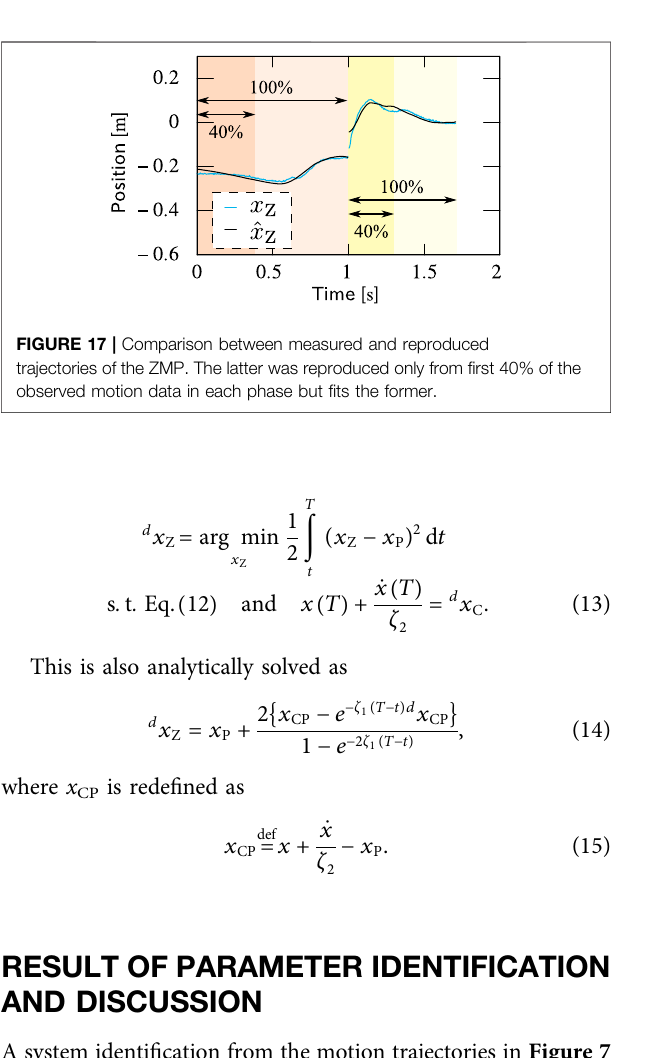
FIGURE 16 | x d x d x P1 , x P2 , C1 and C2 estimated from partial observations in time of experiments with different strides. The abscissa means the percentage of the observation with respect to the whole motion data.